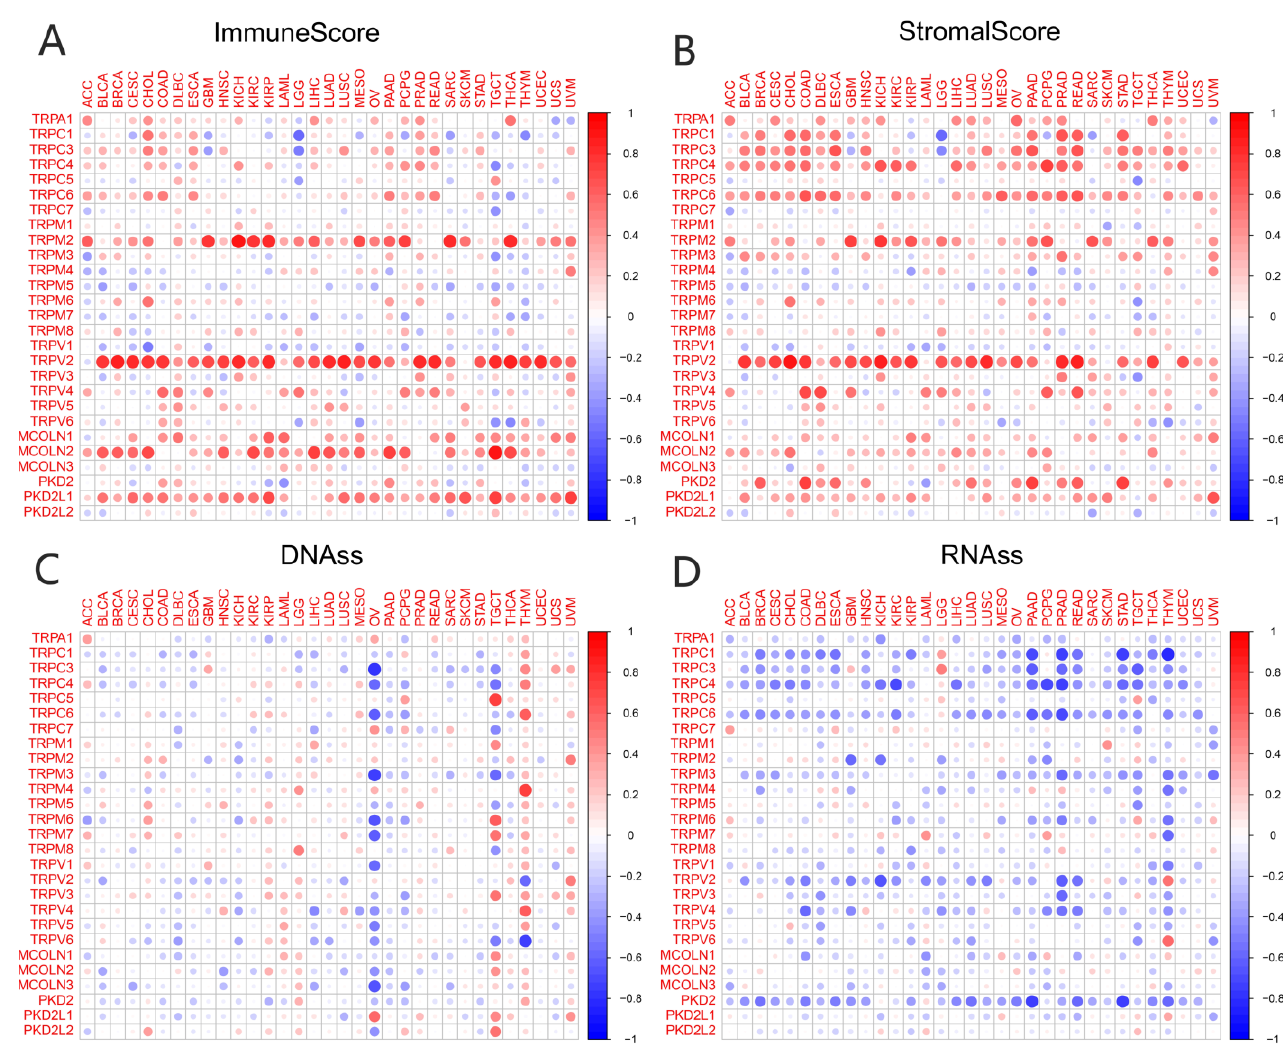
Figure 4. Correlation of the expression of TRP family genes with TME and stemness score in pan- cancer tissues. ( A , B ) I expression of TRP family genes correlated with various mesenchymal and immune cancer scores. Red and green dots indicate a positive and negative correlation between the gene expression and mesenchymal score, respectively. ( C , D ) The correlation between the expression of TRP family genes and RNAss and DNAss in pan-cancer tissues. Red and blue dots indicate a positive and negative correlation between the gene expression and immune score, respectively.